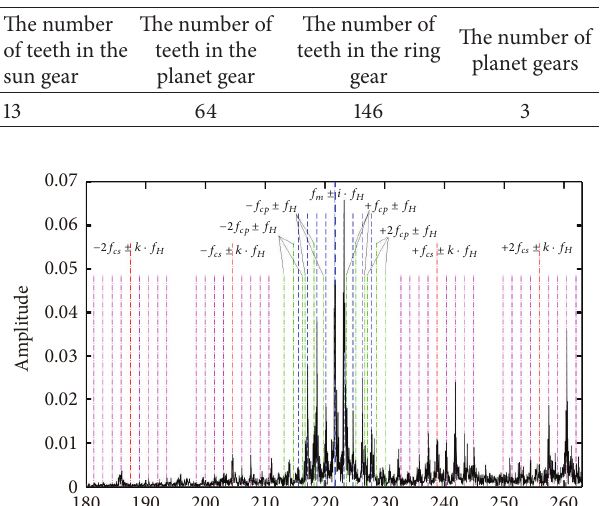
Table 1: Parameters of the planetary gearbox.